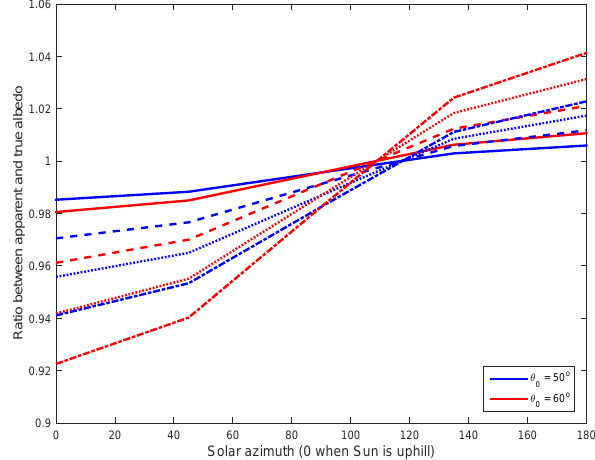
Figure 5. Ratio between apparent and true albedo calculated ac- cording to Eq. (2) in Grenfell et al. (1994) as a function of solar azimuth. Blue and red lines correspond to solar zenith angles ( θ 0 ) of 50 and 60 ◦ , respectively. Surface slope angles of 0.5, 1, 1.5, and 2 ◦ are marked with continuous, dashed, dotted, and dashed-dotted lines,